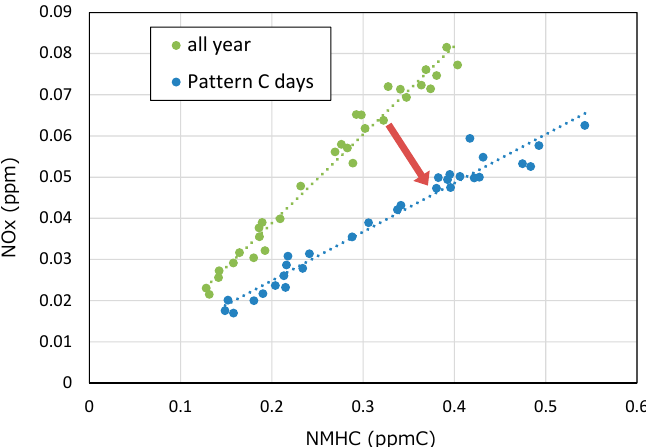
Figure 28. Relationship between NMHC and NOx all the year round and on extracted days. NMHC concentration: average for seven General sta. of three-hour average from 6 a.m. to 9 a.m. NOx concentration: average for all nine General sta. of three-hour average from 6 a.m. to 9 a.m. All year: annual average. Pattern C days: annual average on extracted days.